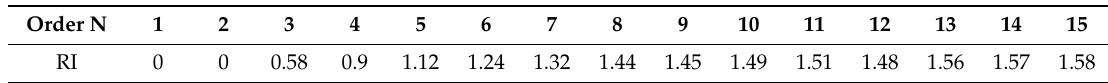
Table 2. Stochastic indicator